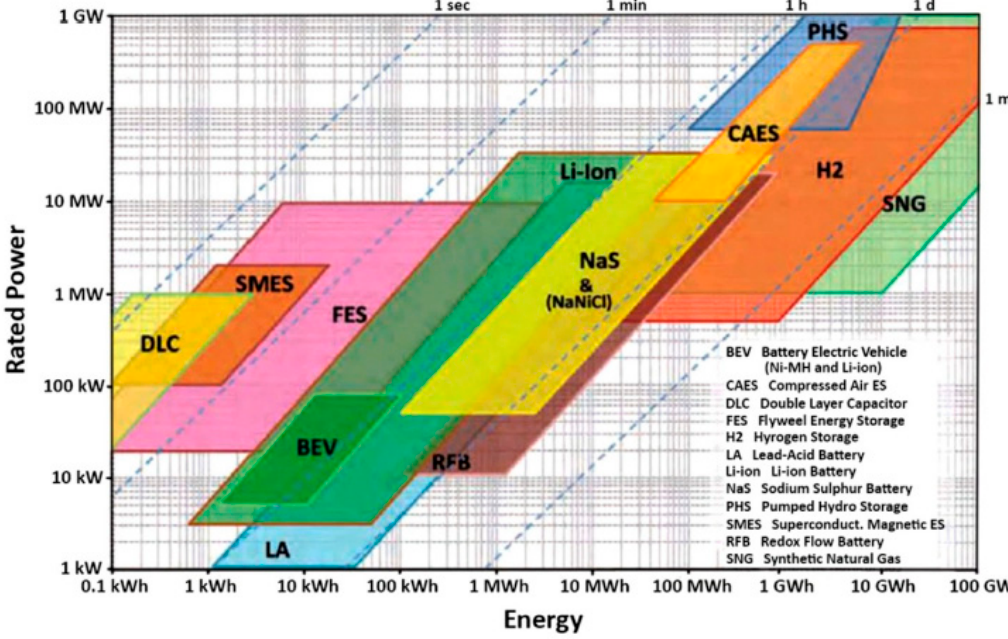
Figure 19. Energy storage system (ESS). Reprint with permission [94]; 2019, Elsevier.